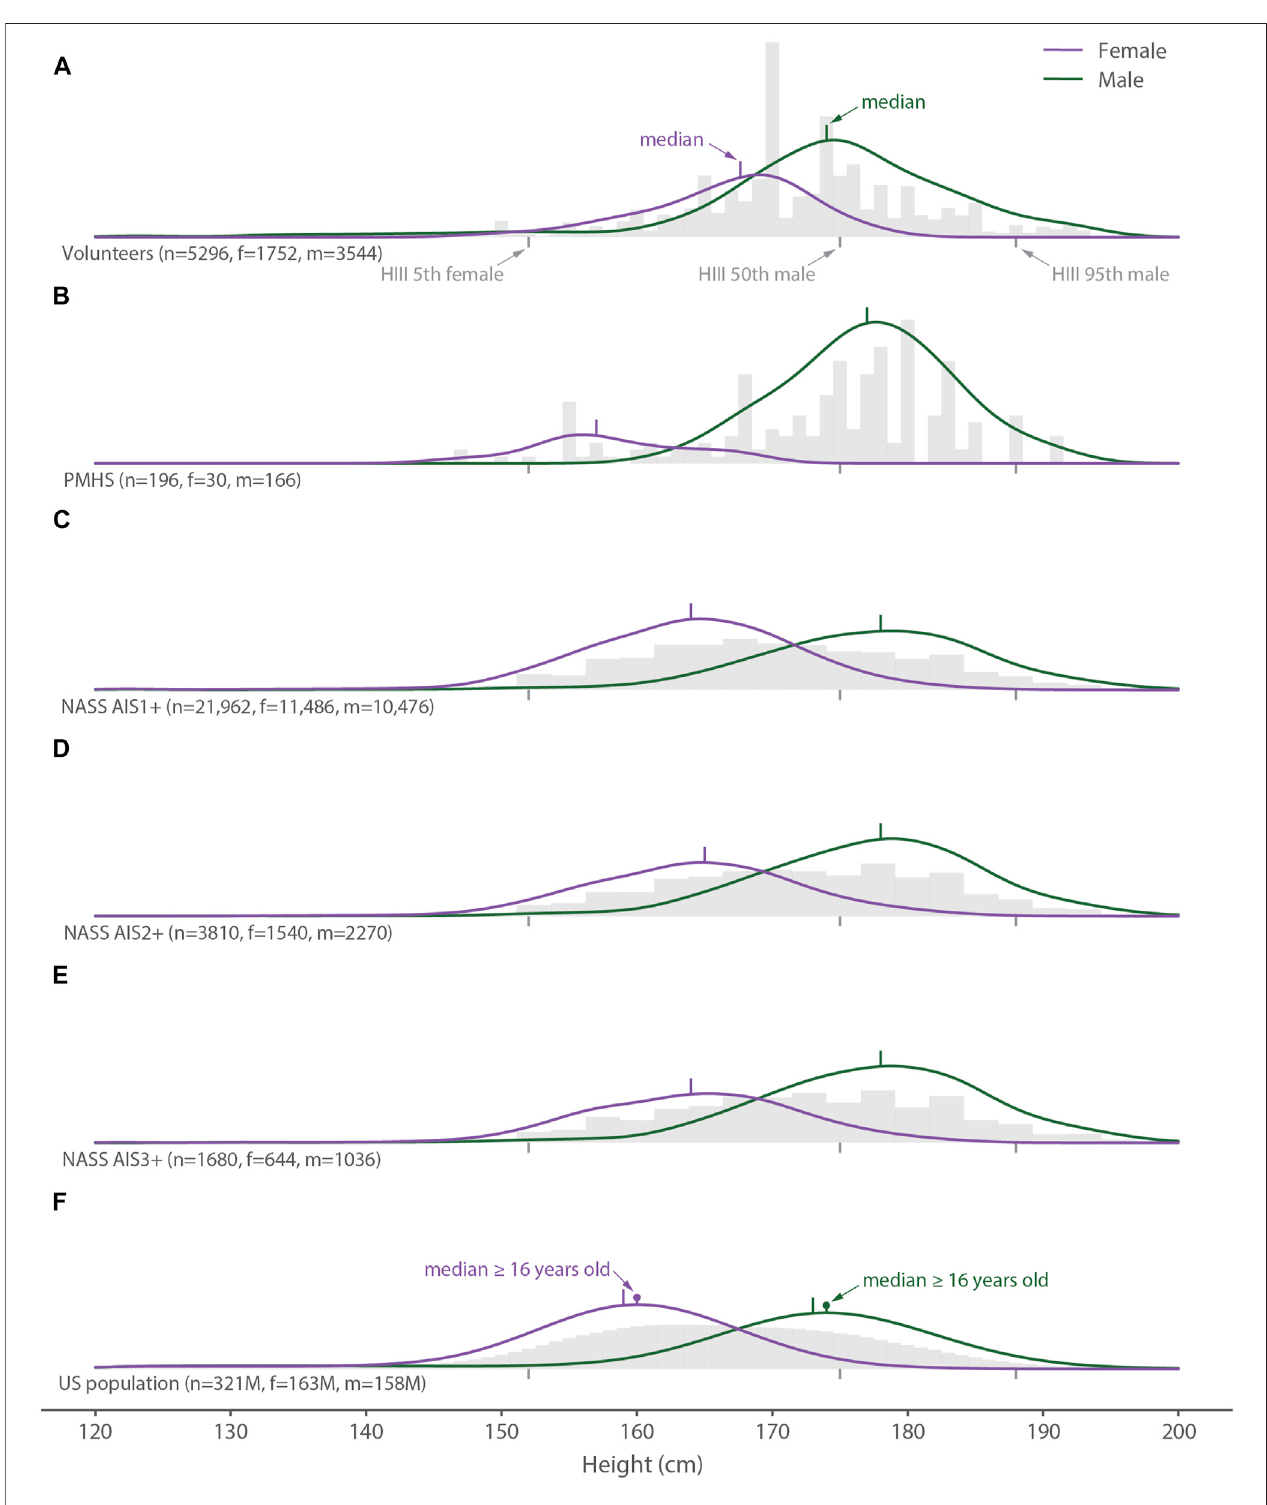
FIGURE 3 | Distribution of all height data (gray histograms), females (purple lines) and males (green lines) for (A) the volunteer tests, (B) the PMHS tests, (C) the NASS AIS1+ data, (D) the NASS AIS2+ data, (E) the NASS AIS3+ data, and (F) the United States population. The gray vertical bars below each histogram show the heights of the 5th percentile female, 50th percentile male, and 95th percentile male Hybrid III crash test dummies.